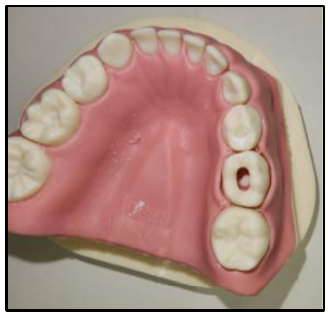
Figure 4. Plastic tooth pulpotomy. Table 1. Mean values (±SD) for each evaluation criterion of the study and control groups and results of the t -test.